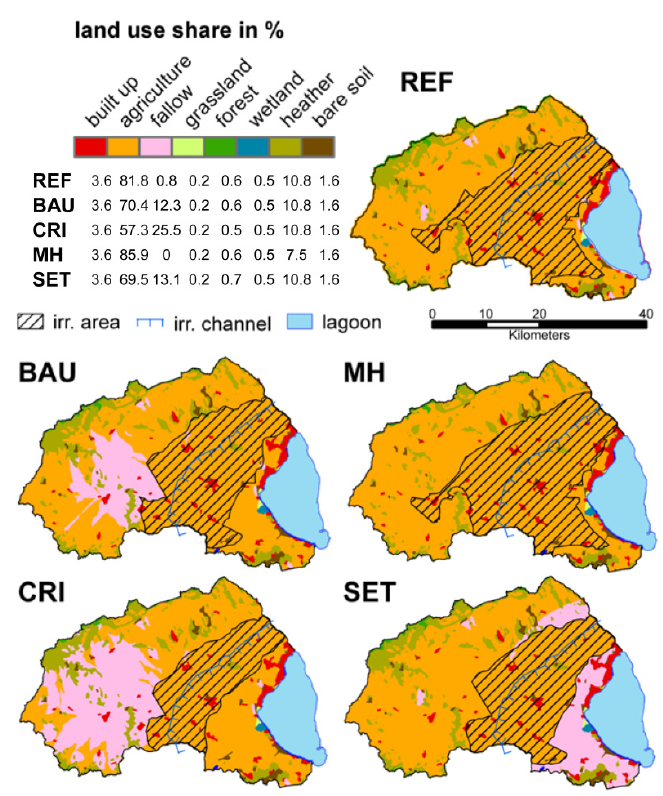
Figure 4. Land use maps for the reference (REF) and scenario (BAU, CRI, MH and SET) conditions for the Mar Menor catchment, as well as shares of land use classes for the reference conditions and the four socio-economic